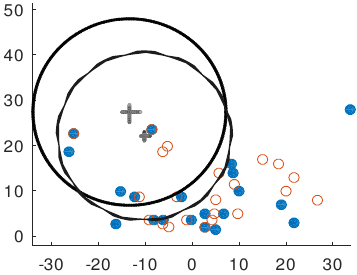
Figure 7. The closed dots are the 20 cell phone position data at the earlier time. The open dots are the 20 cell phone position data at the later time. From the suggested model, I analyze the multiperiod optimized crowd crush monotiring at those times. The solid line circle with all 20 cell phone position data at the earlier time (closed dots) has the center ( − 13.413, 27.355) with the minimax radius 20.582, and the wavy line circle with 20 points (open dots) at the later time has the center ( − 10.222, 22.038) with the minimax radius